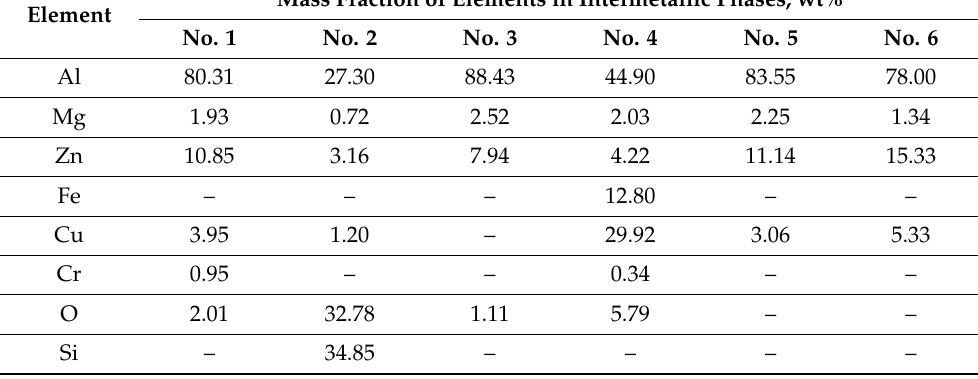
Figure 7. Precipitates of intermetallic phases in 7075 aluminum alloy in initial state, SEM. Table 4. Results of EDS analysis of intermetallic phases. Table 4. Results of EDS analysis of intermetallic phases.